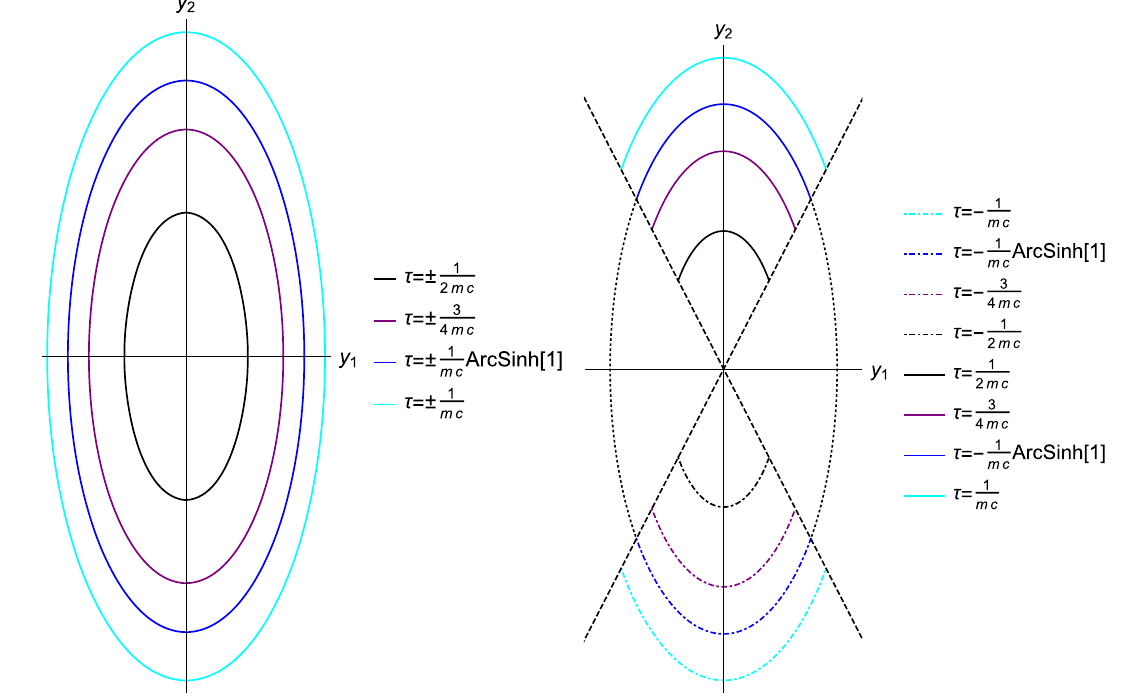
Fig. 3 Indicative static solutions of the SL ( 2 , R )/ U ( 1 ) A model. The left panel corresponds to a rotating solution, while the right one to an oscillating one, which is a folded string. Notice that as λ > 0 the angle ψ of the oscillating solution “oscillates” around π/ 2. The equation of the blue ellipses is (87)